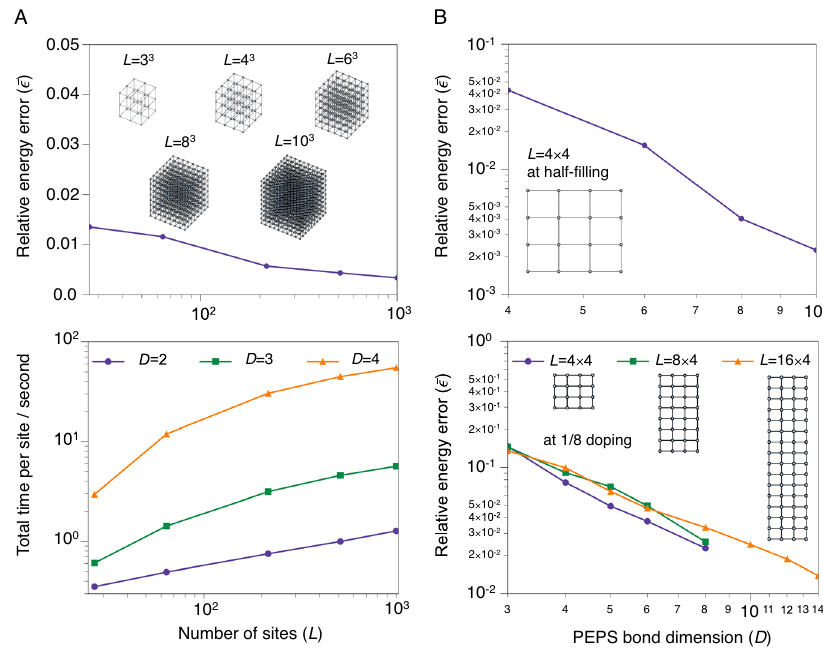
Fig.4|Computationalcomplexityofclassicalheuristicsformodelsofstrongly correlated material systems. A Relative energy error of a tensor network (PEPS) withrespecttosystemsizes3 3 to10 3 forthe3DHeisenbergcubemodelwithabond dimension ( D ) of 4. In bottom panel: total computational time in seconds, divided by number of sites, as a function of system size, demonstrating poly( L ) (close to